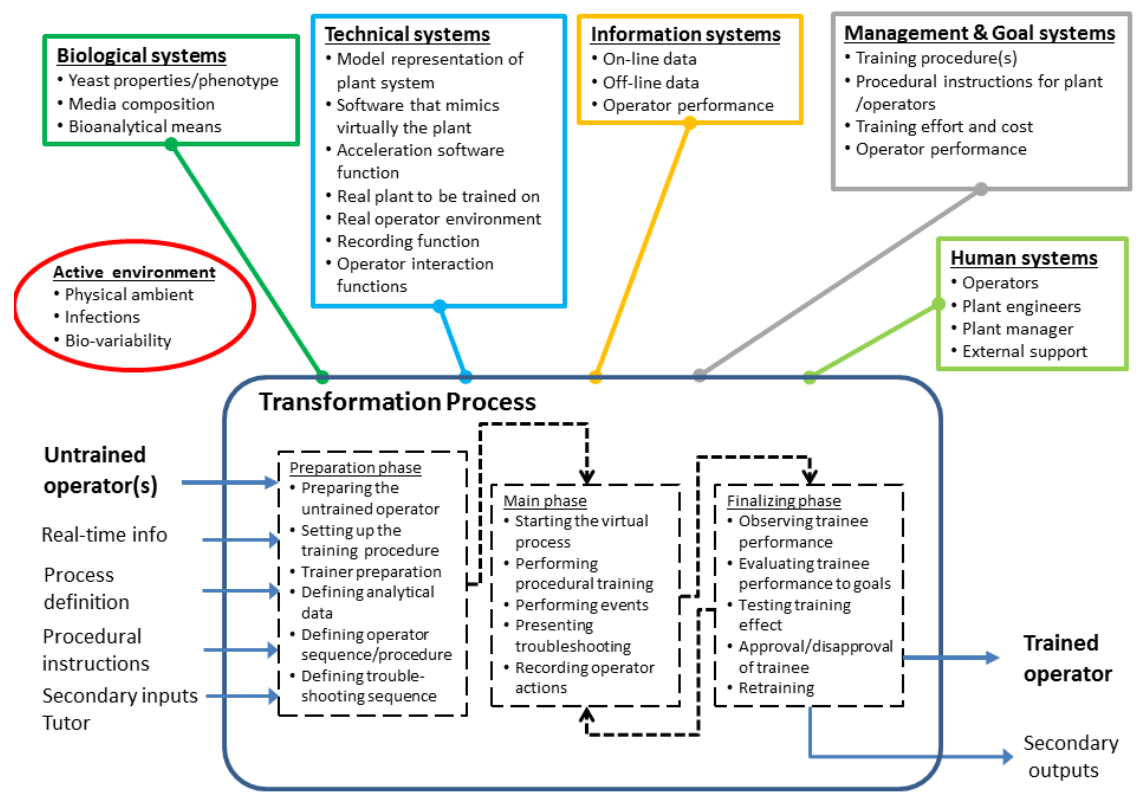
Figure 3. Hubka-Eder map representing the operator training of the bio-ethanol plant. The map shows both the systems involved in the plant as well as the systems for the